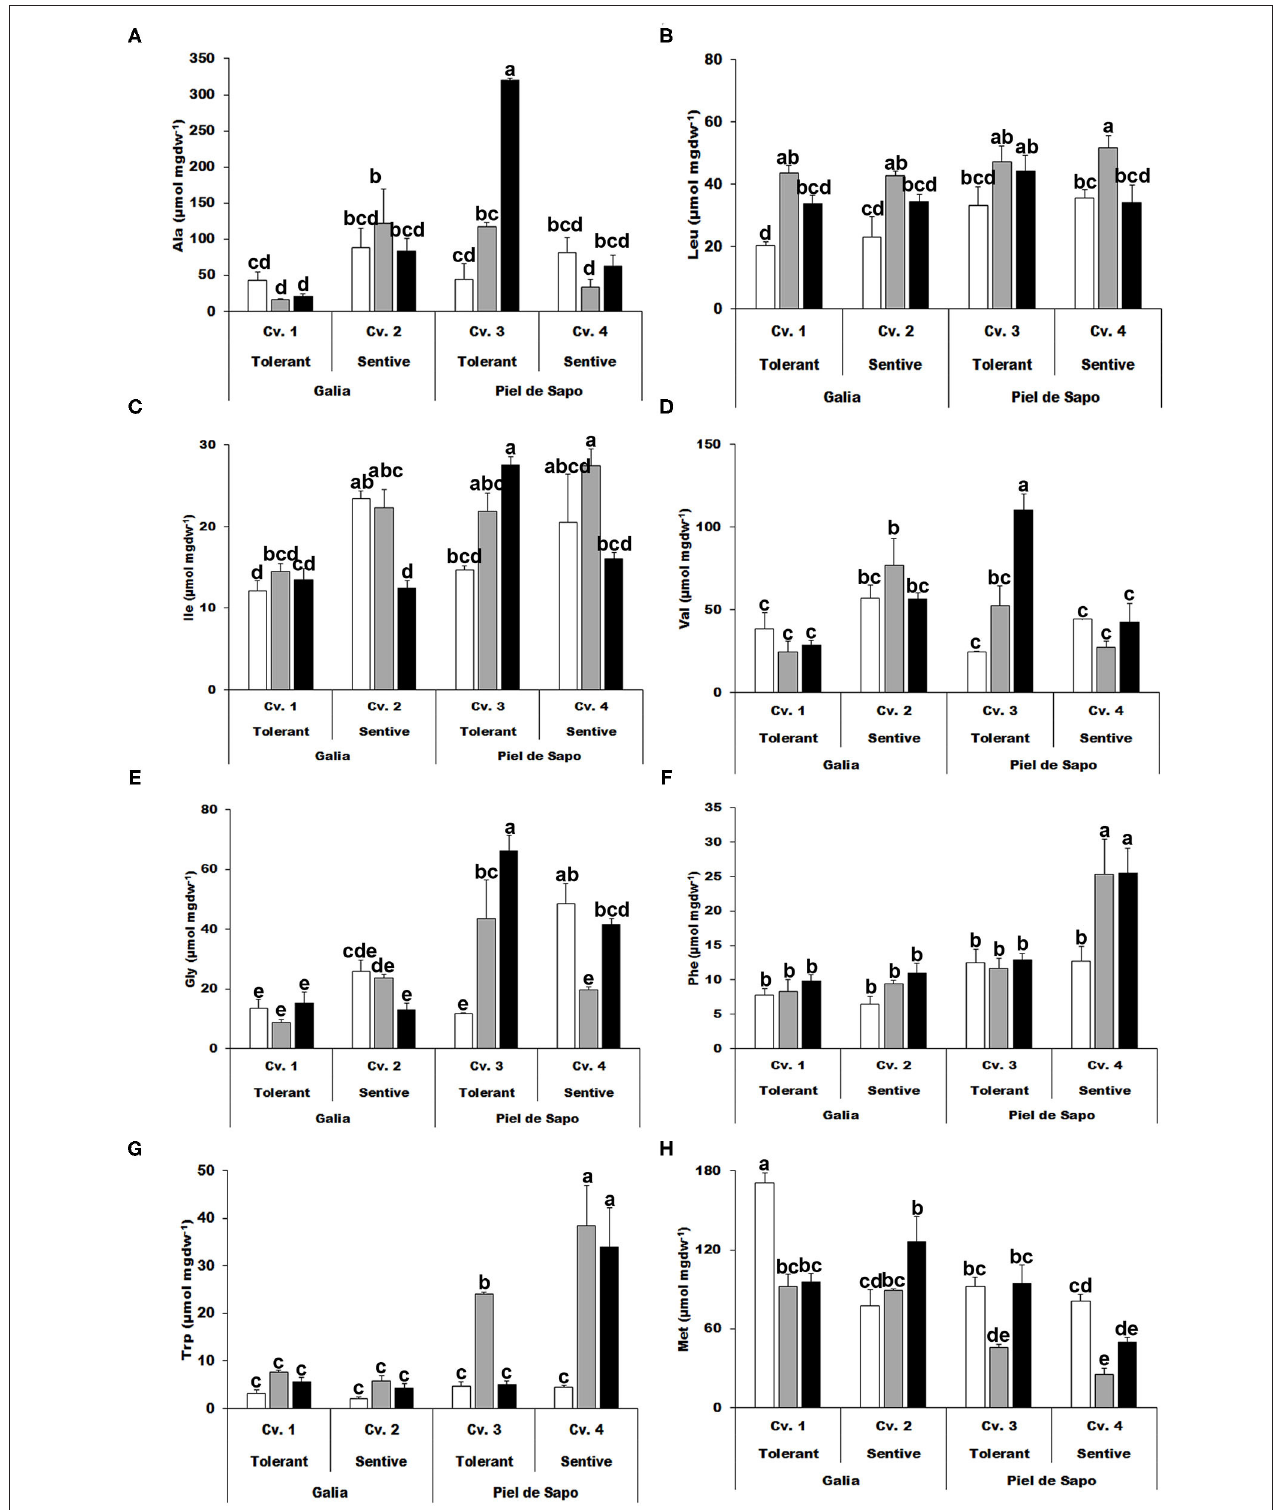
FIGURE 2 | Hydrophobic amino acids. Alanine (Ala) (A) ; leucine (Leu) (B) ; isoleucine (Ile) (C) ; valine (Val) (D) ; glycine (Gly) (E) ; phenylalanine (Phe) (F) ; tryptophan (Trp) (G) ; and methionine (Met) (H) of Galia tolerant genotype (Cv. 1), Galia sensitive genotype (Cv. 2), Piel de Sapo tolerant genotype (Cv. 3) or Piel de Sapo sensitive genotype (Cv. 4) under control (white bars), salt stress (gray bars) and drought stress (black bars) conditions. Data with different letters differ significantly ( p < 0.05), as determined by Duncan’s MRT test ( n = 3). Scale bars are mean ± SE. Experiment was replicated with similar results.